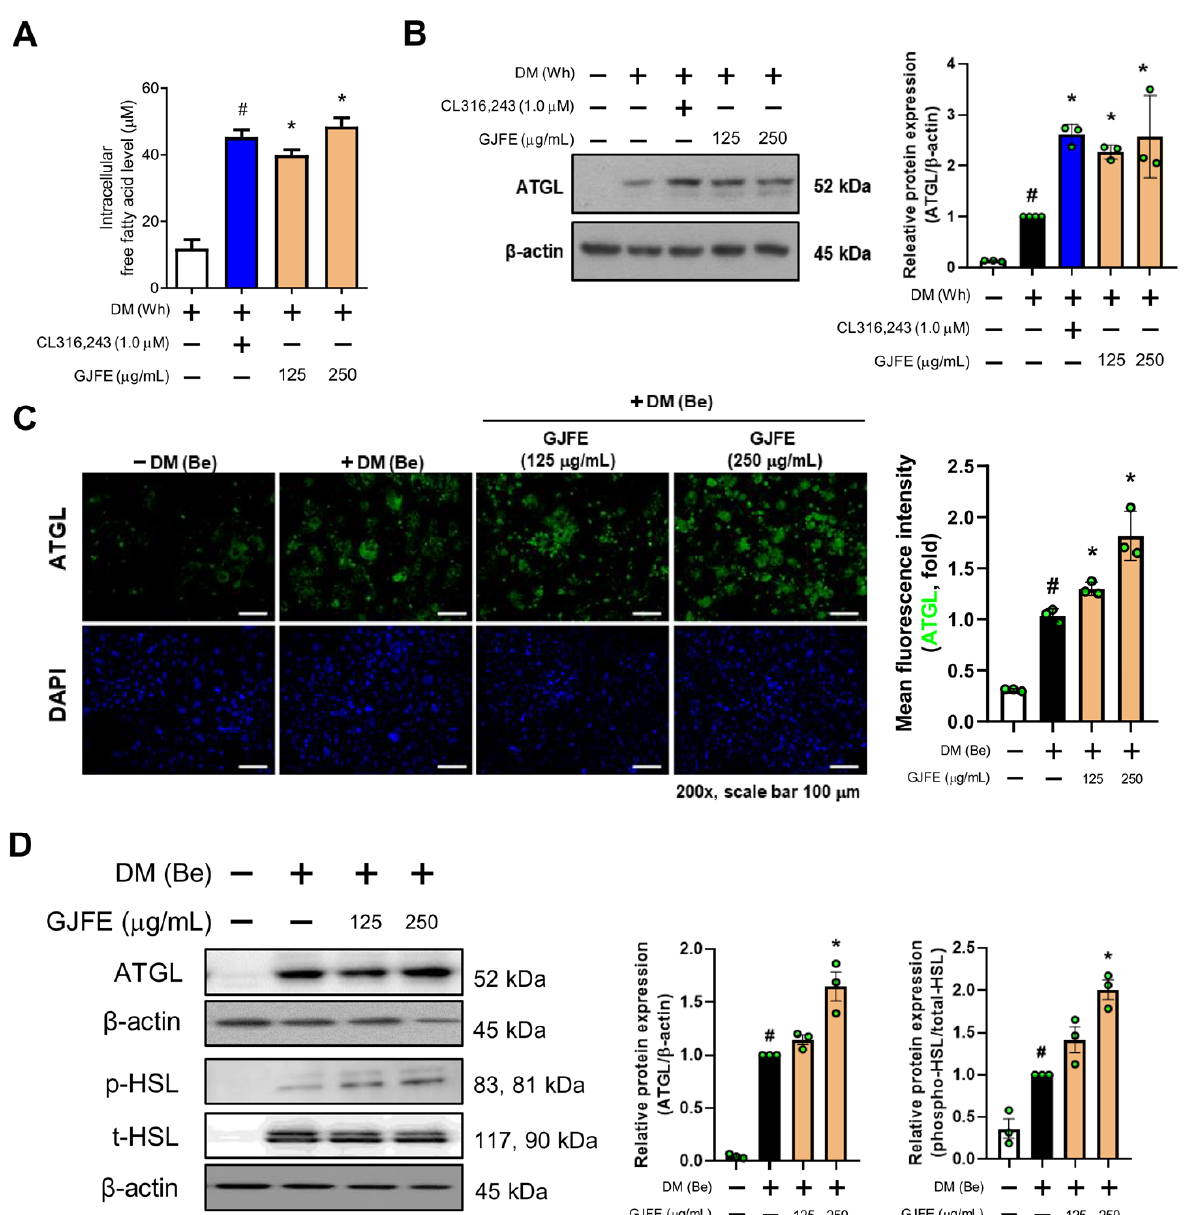
Figure 4. Effect of GJFE on lipolysis markers in differentiated 3T3-L1 cells. ( A ) Level of intracellular free fatty acid and ( B ) protein level of ATGL in white-induced 3T3-L1 cells were analyzed by Western blot analysis. ( C ) ATGL (green) and DAPI (blue) in beige-induced 3T3-L1 cells were detected by immunofluorescence staining (magnification 200 × , scale bar 100 µ m). ( D ) Protein levels of ATGL, p-HSL, and t-HSL in beige-induced 3T3-L1 cells were analyzed by Western blot analysis. β -actin was used as a loading control for Western blot analysis. # p < 0.05 vs. DM-untreated 3T3-L1 cells, * p < 0.05 vs. DM-treated 3T3-L1 cells. GJFE, Gardenia jasminoides fruit extract.